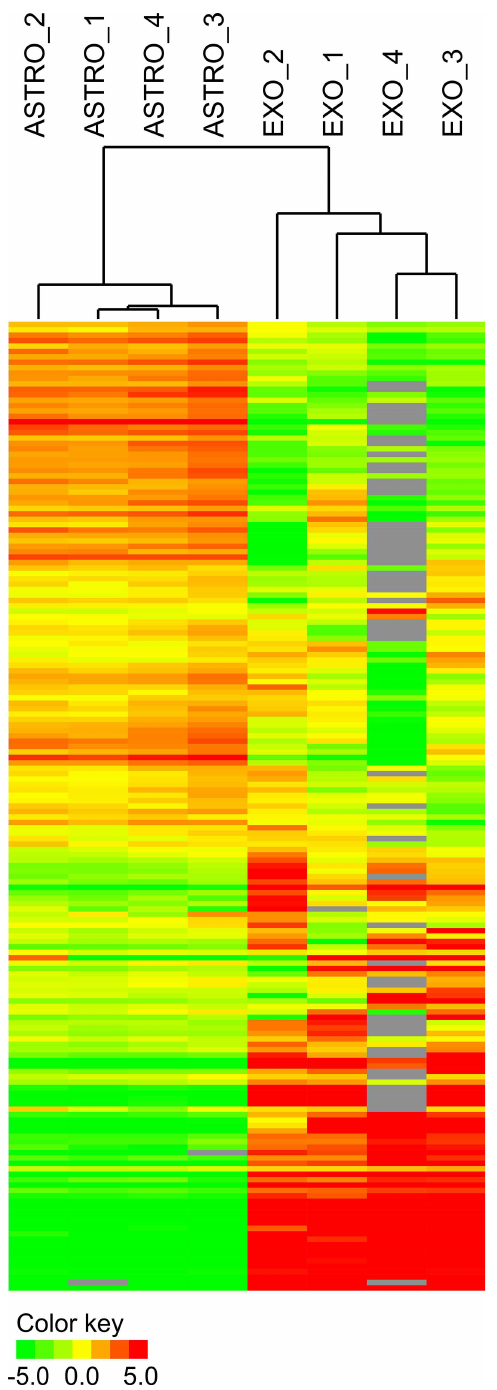
Fig 2. Astrocytesand astrocyte-secreted exosomes differ vastly in their miRNA expression. ASTRO_1, 2, 3, 4 –astrocyte samples; EXO_1, 2, 3, 4 –exosome